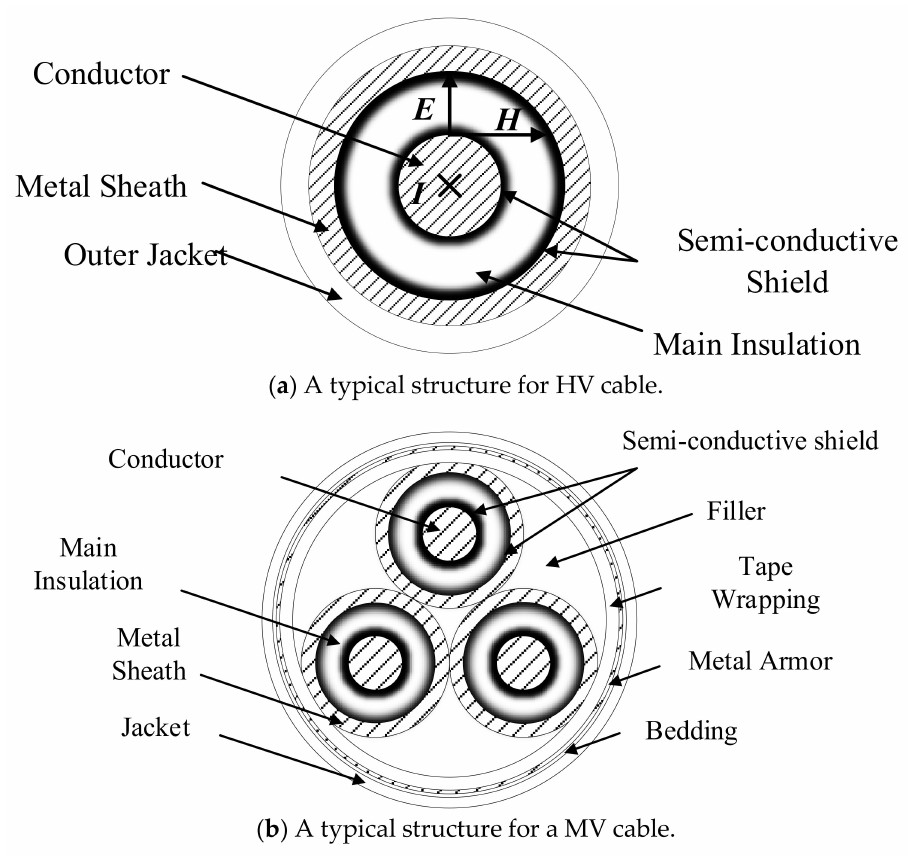
Figure 1. Cross-sectional structure diagram of typical power